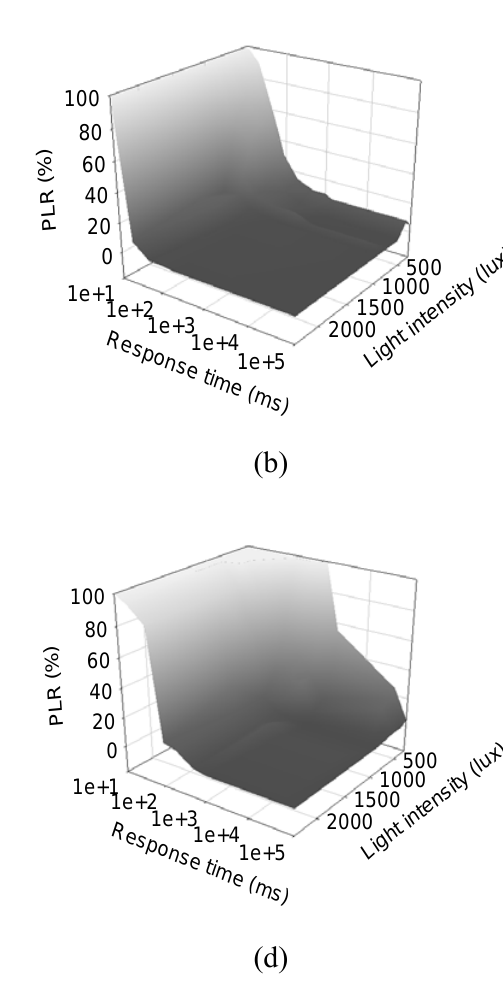
Figure 6. The packet loss rate, PLR, of temperature (a), humidity (b), photo (c) and flow sensor node (d) against the environmental light